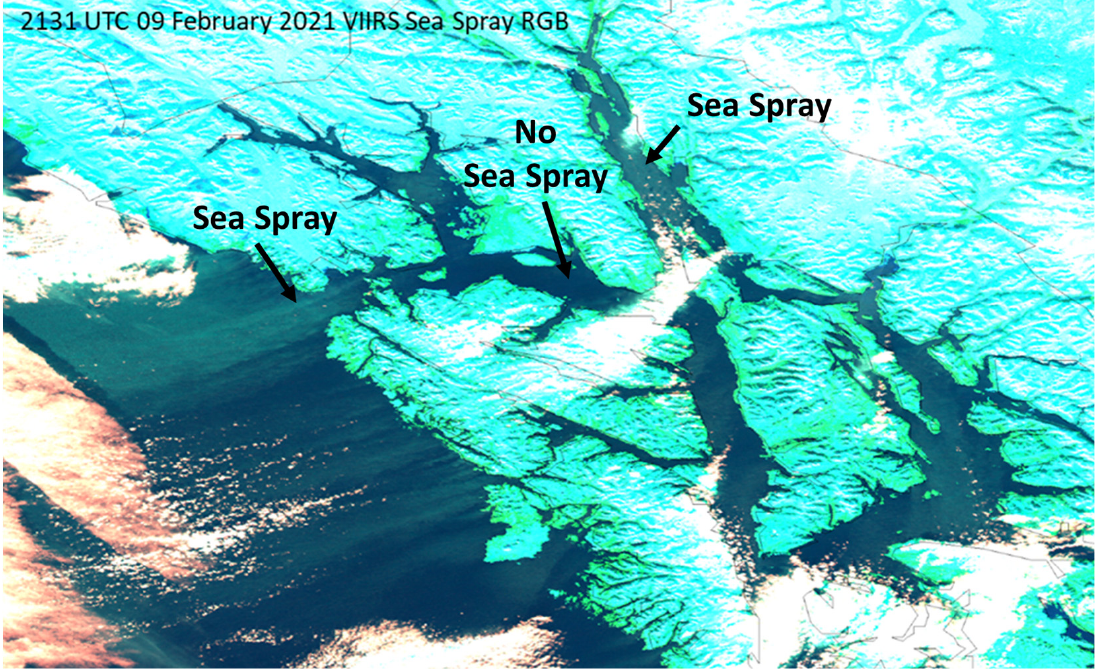
Figure 2. 2131 UTC 9 February 2021 VIIRS Sea Spray RGB over southeast Alaska. See text for image